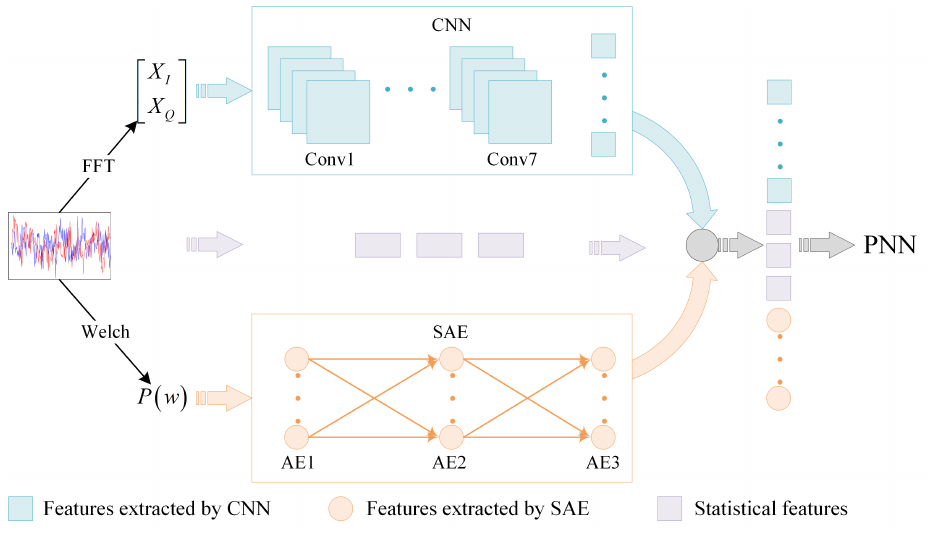
Figure 2. Sketch map of the proposed